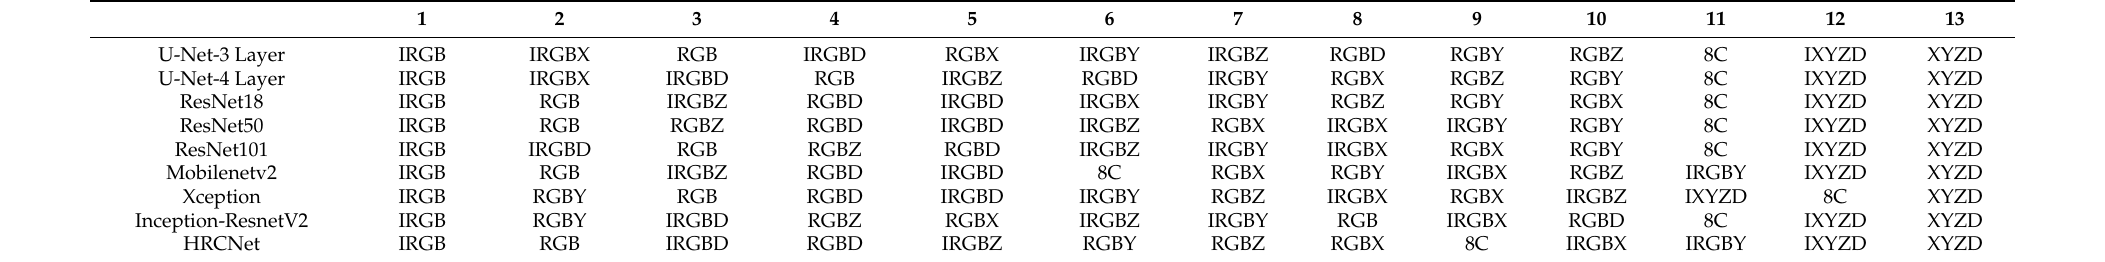
Table 7. Ranking of the mIoU performance of 13 channel combinations for seven